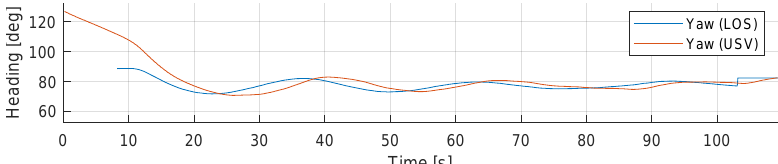
Figure 18. USV Control scenario: Comparison of heading angle from the LOS guidance system with field-test data. After reaching the / target position, the yaw angle is equal to the constant velocity-path relative angle χ r for DP mode.